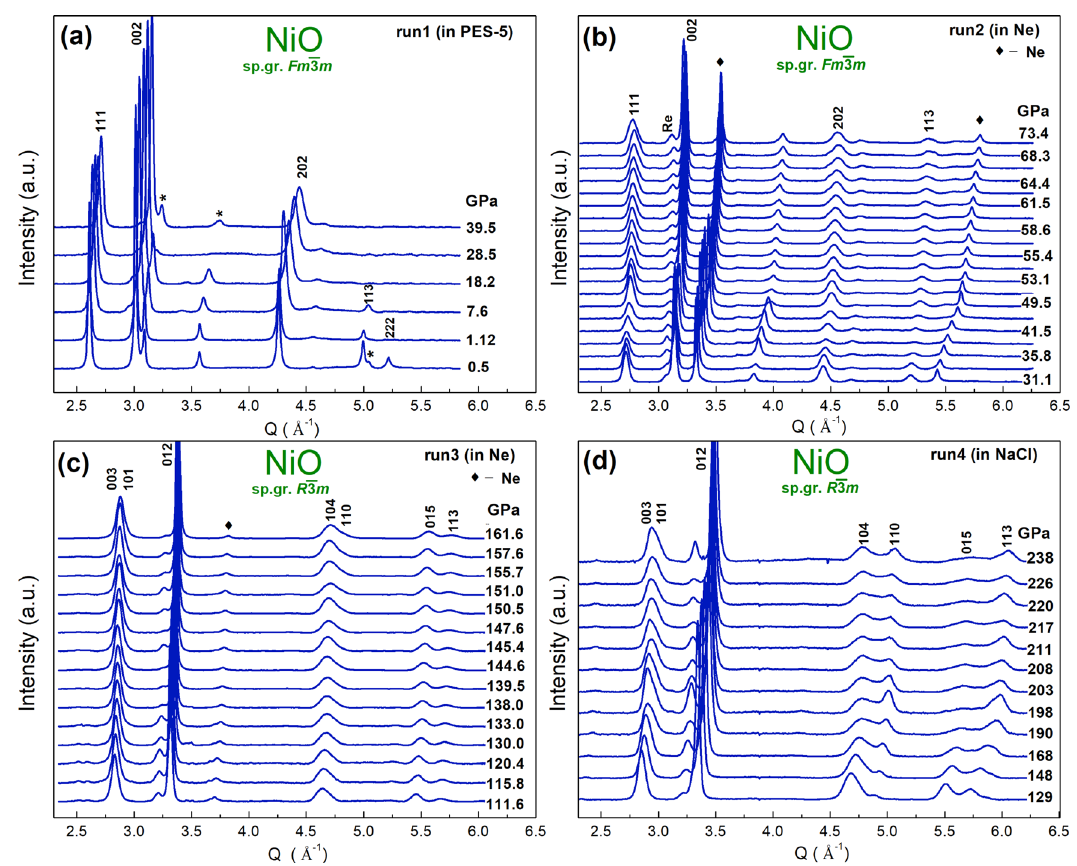
Fig. 2 The evolution of the X-ray diffraction (XRD) patterns of NiO with pressure increase at room temperature for different runs. a XRD patterns of run 1 (impurity peaks of Ni are marked with asterisks), ( b ) XRD patterns of run2, ( c ) XRD patterns of run3, ( d ) XRD patterns of run